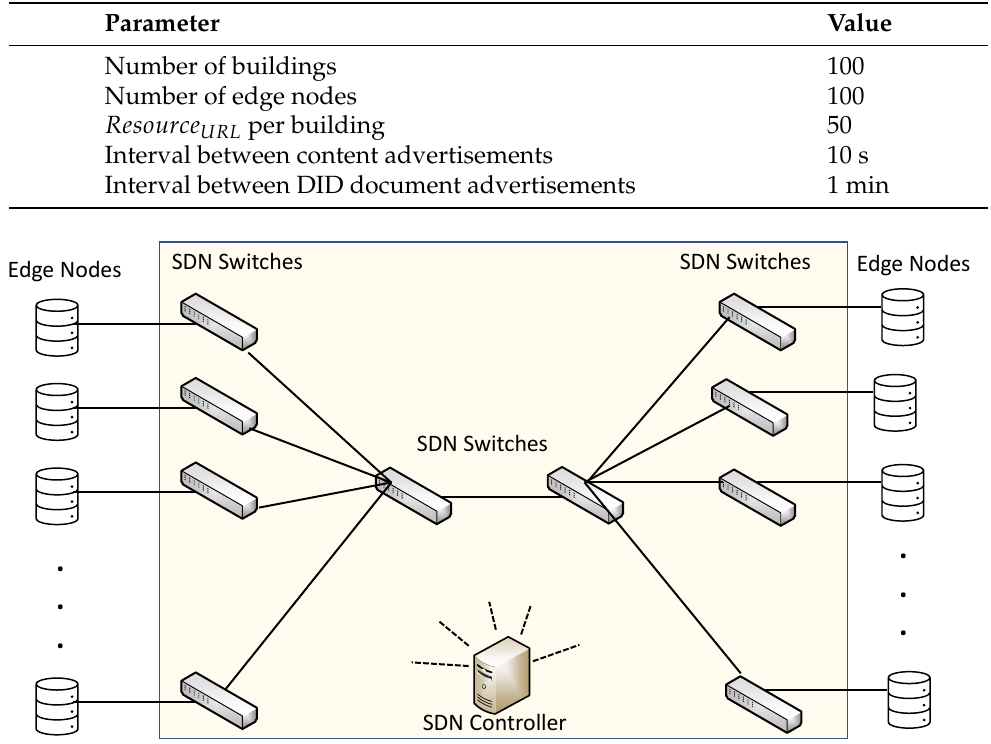
Figure 3. Evaluation topology. The links between the SDN switches and the controller are not shown for clarity